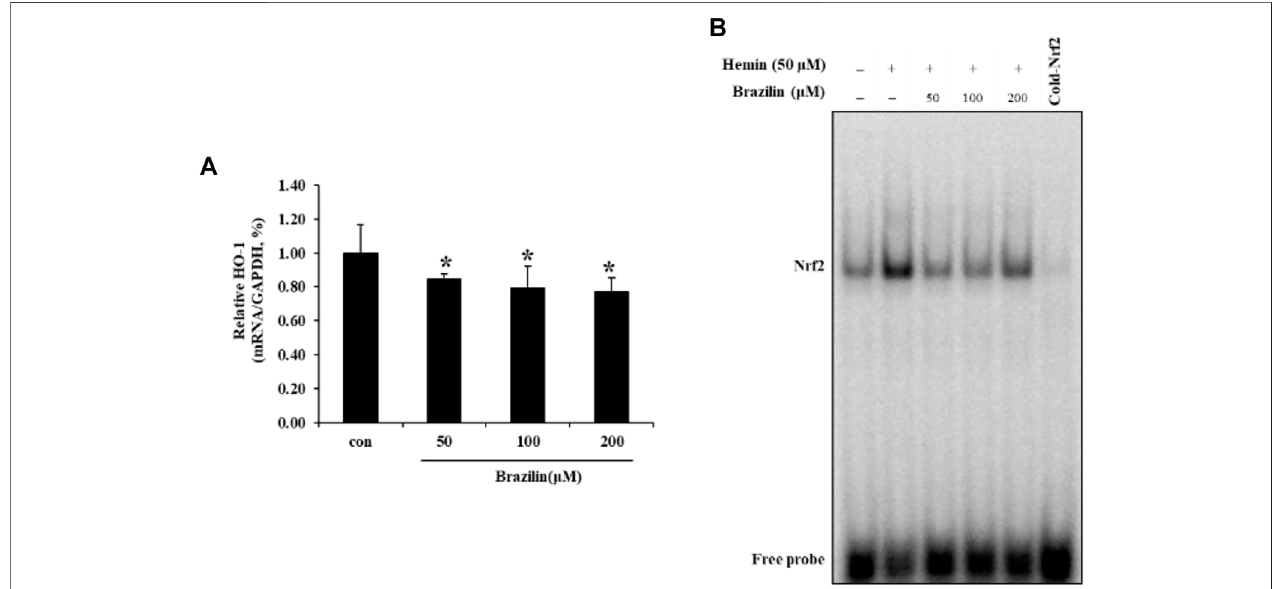
FIGURE 5 | Brazilin regulates (A) HO-1 expression and (B) Nrf2 DNA binding activity in SW480 cells. Cells were treated with indicated dosages of brazilin for 1 h, and then further incubated with 50 μ M hemin for 24 h. Relative ratio of HO-1 mRNA levels were calculated by qPCR with GAPDH as an internal control. Data are presented as Means ± SD of three independent experiments. * p < 0.05 vs. control group. The experiments were repeated for at least of three times.